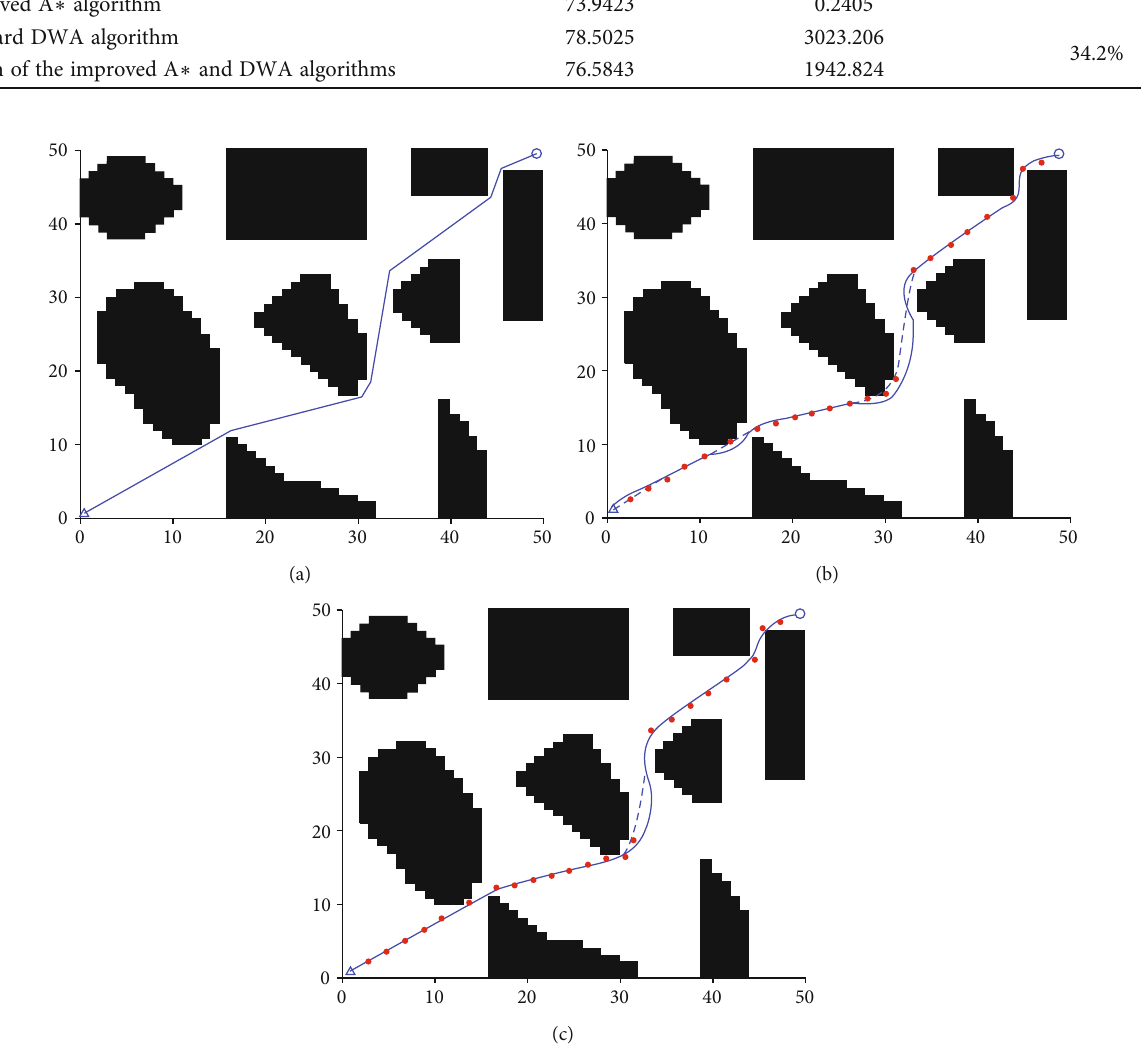
Figure 10: Comparison of the path planning algorithms on known maps. (a) Improved A ∗ algorithm. (b) Standard DWA algorithm. (c) Fusion of improved A ∗ and DWA